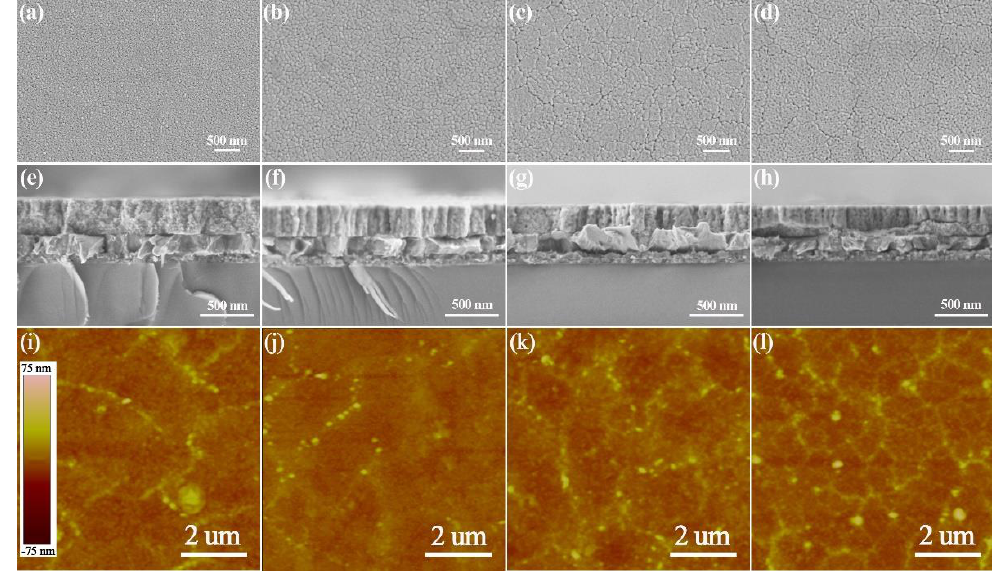
Figure 3. microstructures of PMN-PT-xFe thin films with different doping concentration of Fe ele- ment. ( a,e,i ) x = 0; ( b,f,j ) x = 2; ( c,g,k ) x = 4; ( d,h,l ) x = 8. Note that the fine grains are obtained in ( a ),